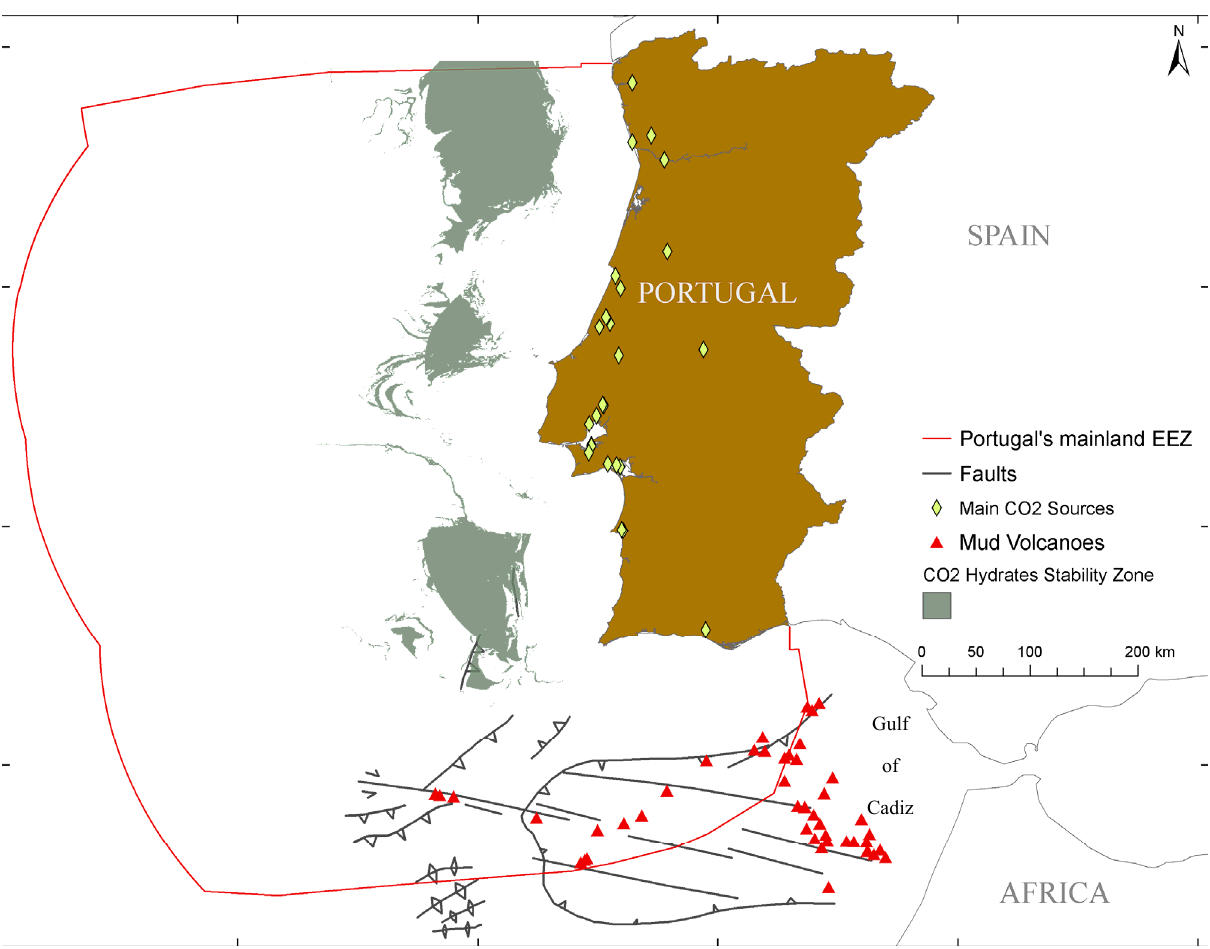
Figure 1. Location of the CO 2 hydrates stability zones defined in Bernardes et al.